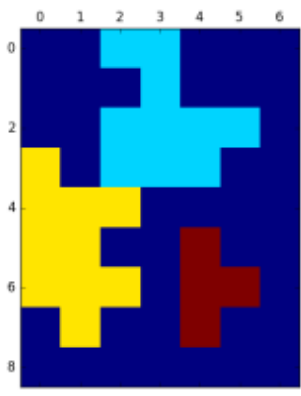
Figure 7. Simple test case – moderately high threshold for inclusion in storm